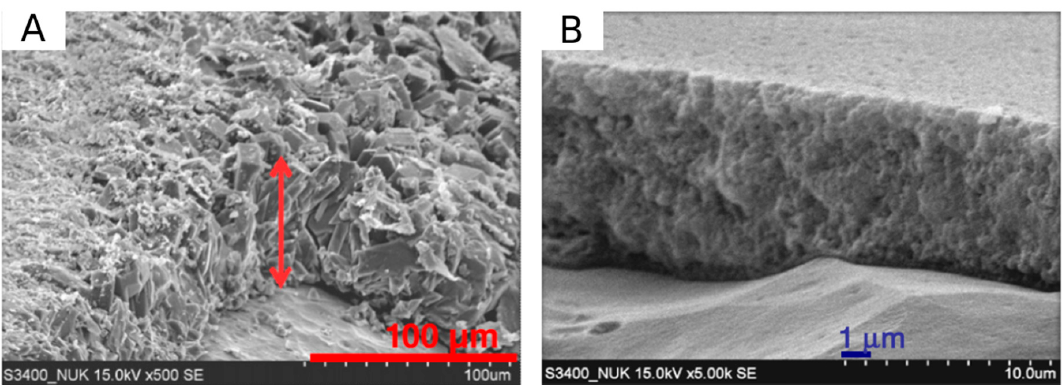
Figure 6. Cross-section SEM image of the zeolite coating produced using the ( A ) hydrothermal and ( B ) dry-gel-conversion process [35]. Reprinted with permission from Elsevier.